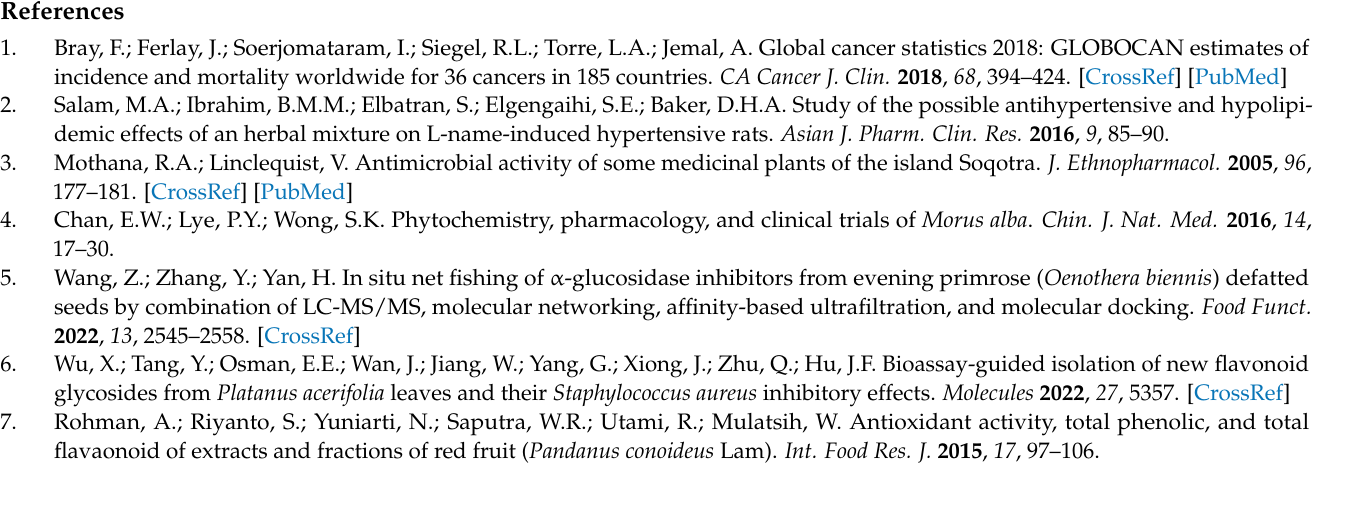
Figure S2: H NMR of PH-HM-10; Figure S3: C NMR of PH-HM-10; Figure S4: HSQC spectrum of